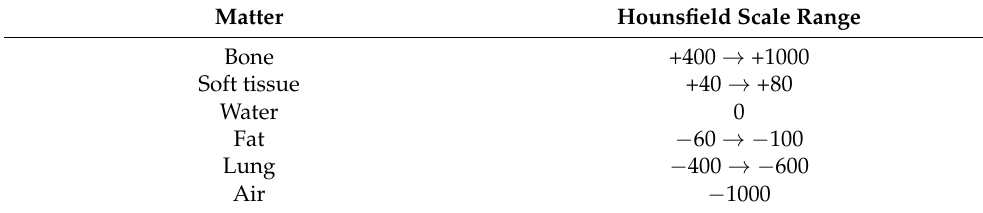
Table 1. Hounsfield